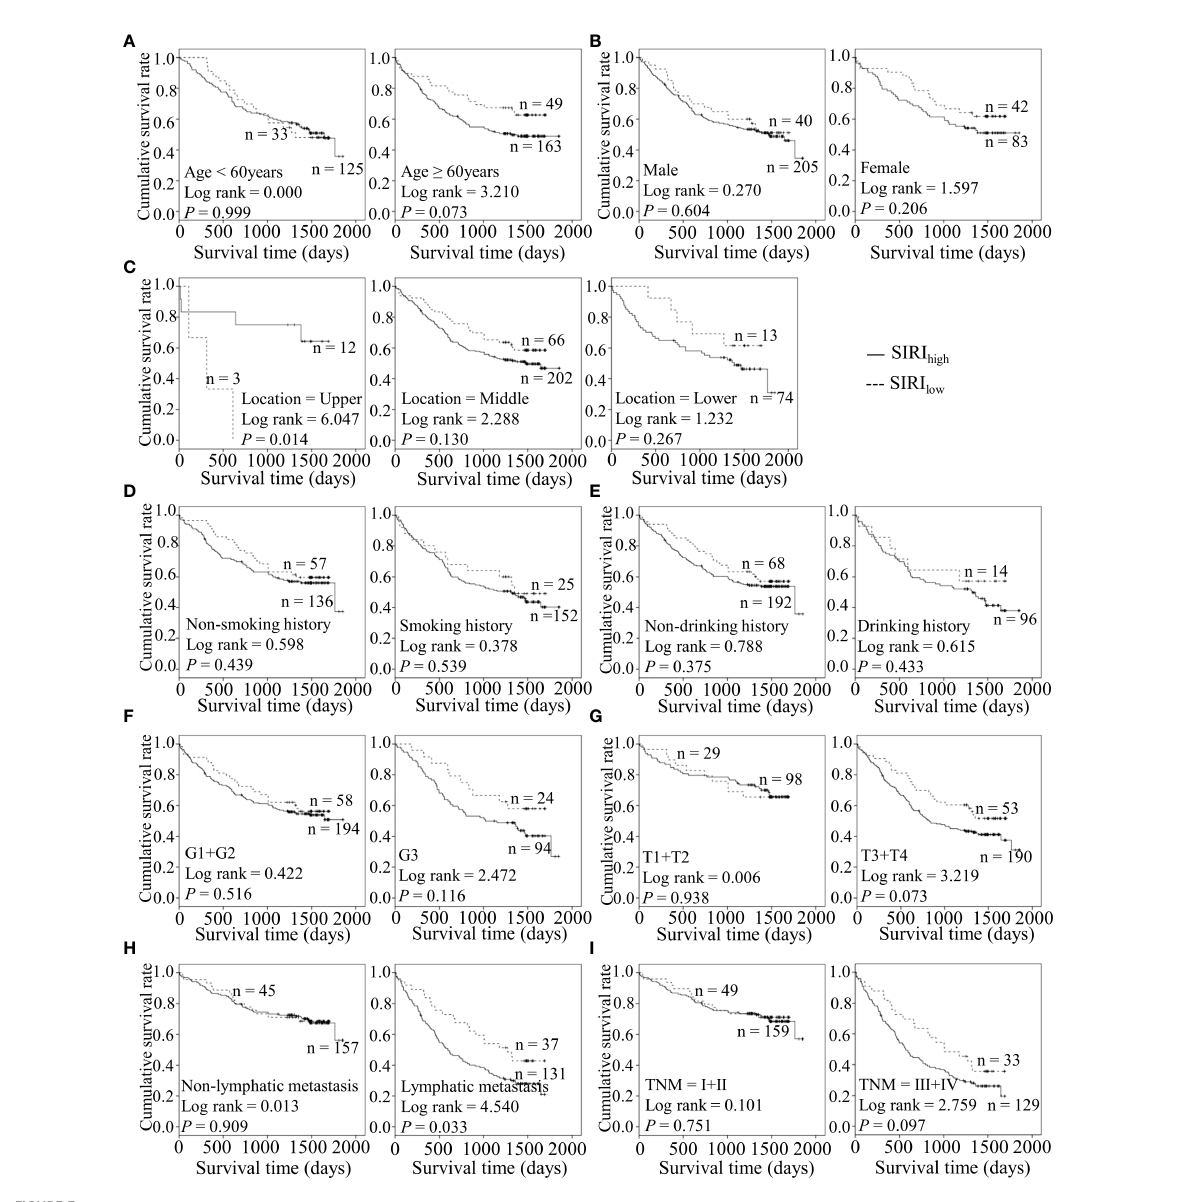
FIGURE 3 Predicating role of preoperative SIRI level for the OS of ESCC patients. (A – I) Kaplan-Meier survival curves of ESCC patients with different SII levels combined with diverse features like age (A) , gender (B) , tumor location (C) , smoking history (D) , drinking history (E) , tumor grade (F) , T stage (G) , lymph node metastasis (H) and TNM staging (I)